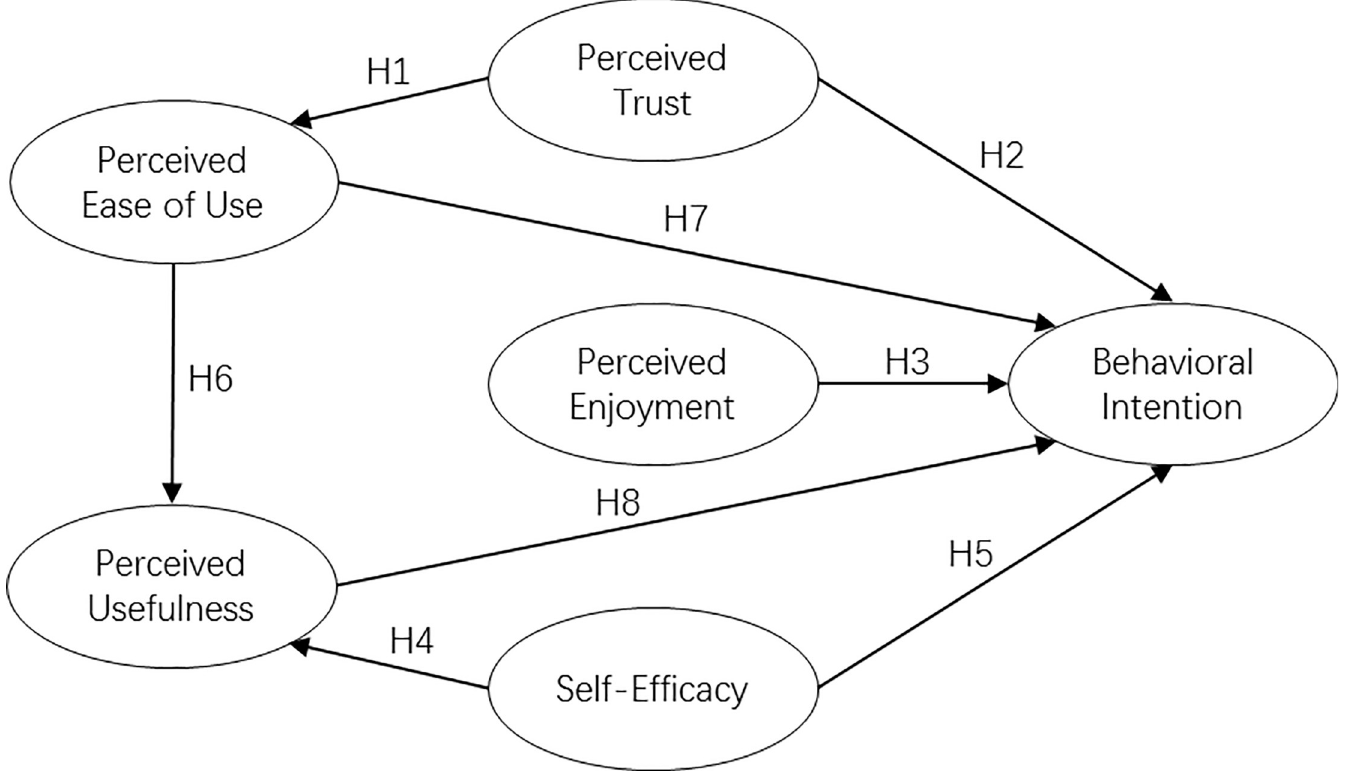
Fig 1. Research structure.